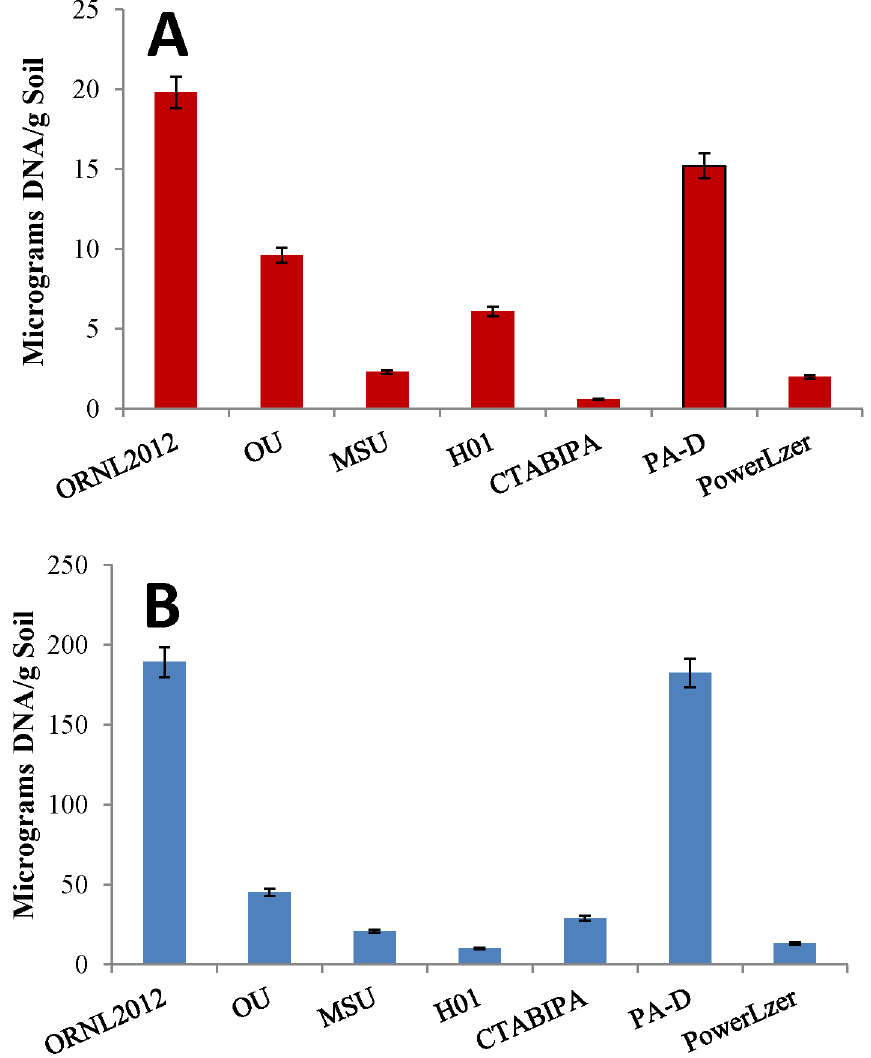
Figure 4. Comparison of methods. Various published and commercial procedures were compared for total DNA recovery from ( A ) clay and ( B ) A- horizon soils. Commercial kits included the Powerlyzer, PowerSoil H DNA isolation kit (MoBio) while the published methods included OU [15], MSU [39], ORNL 2001 [14], CTABIPA [40] and PA-D [37].